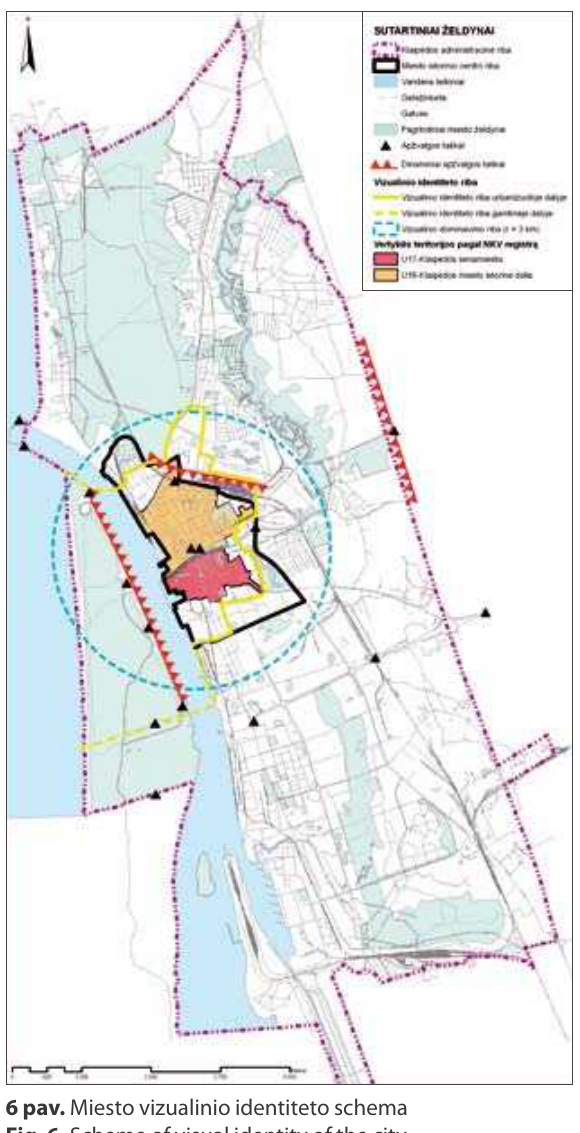
Fig. 6. Scheme of visual identity of the city